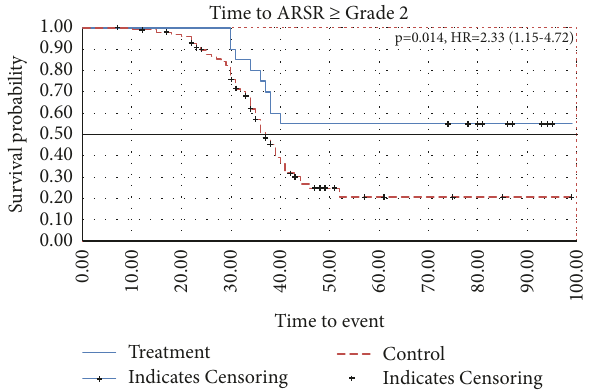
Figure 1: Time to ARSR ≥ Grade 2. p=0.014, HR=2.33 (1.15-4.72). Censoring: patients without documented event will be censored at